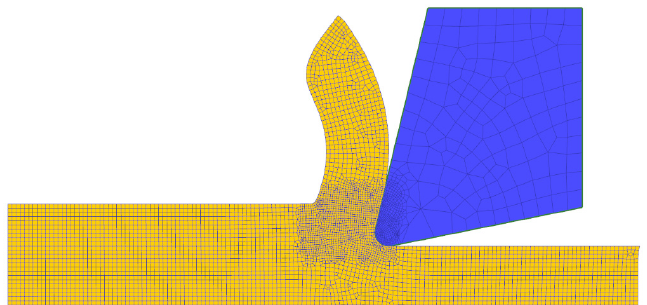
Figure 4. FEM-based model and resulting flow chip formation using the start parameters in the first identification iteration.